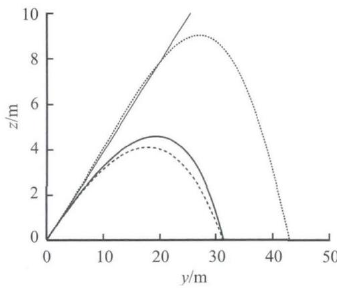
Fig. 2 Projection of the football track in the horizontal plane under three conditions: no rotation Ω 0 = 0; The solid line: 0 = 2-2+16 rad/s; the short line: 0 = 13+0+0 rad/s.